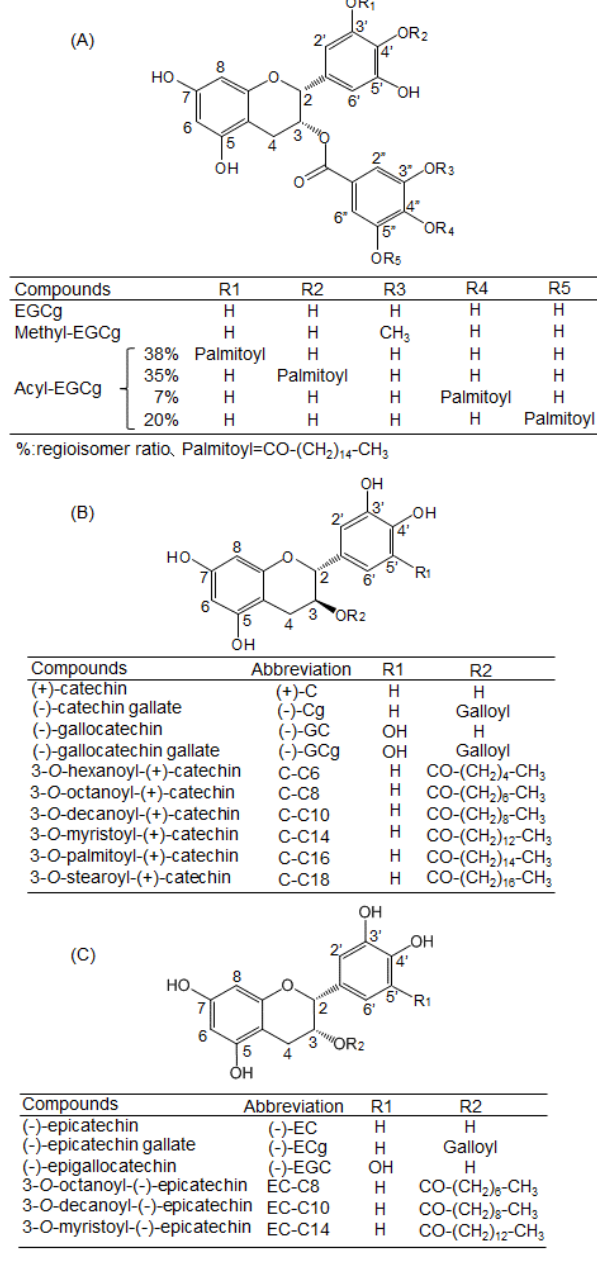
Figure 2. Structures of ( A ) EGCg, ( B ) (+) ‐ C, ( C ) ( − ) ‐ EC, and their derivatives.